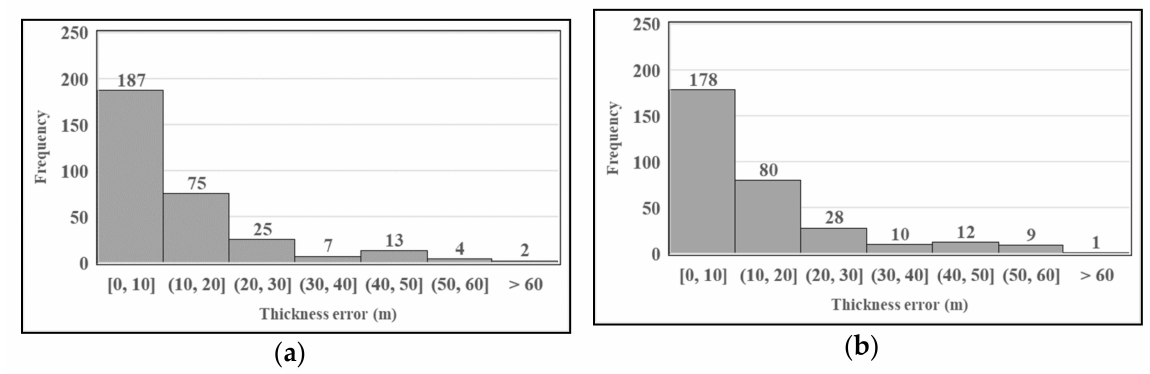
Figure 10. Thickness error distributions for the test set of 1122 boreholes not reaching the bedrock estimated by ( a ) EBK and ( b )